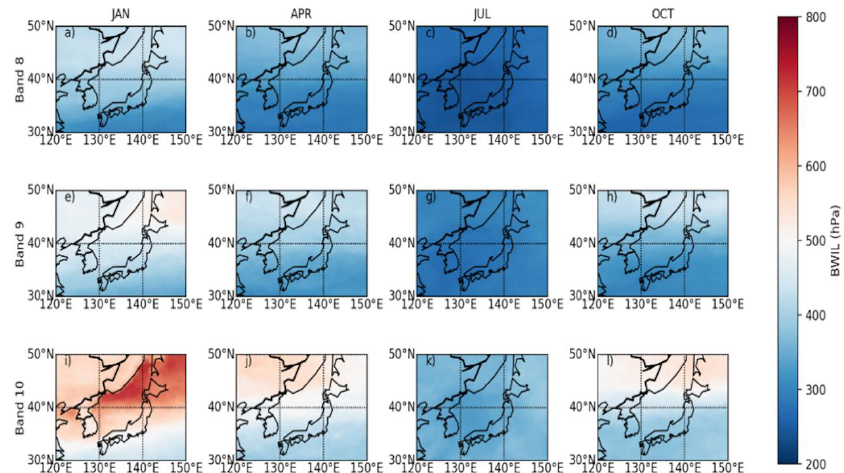
Figure 7. The mean |M| over the typical region of East Asia in January, April, July and October. ( a )– ( d) are for Band 8; ( e )–( h ) are for Band 9; and ( i )–( l ) are for Band 10. Units are K/log(kg/kg). Figure 8. The mean height of BWIL over the typical region of East Asia in January, April, July and October. ( a )–( d ) are for Band 8; ( e )–( h ) are for Band 9; and ( i )–( l ) are for Band 10. Units are hPa.